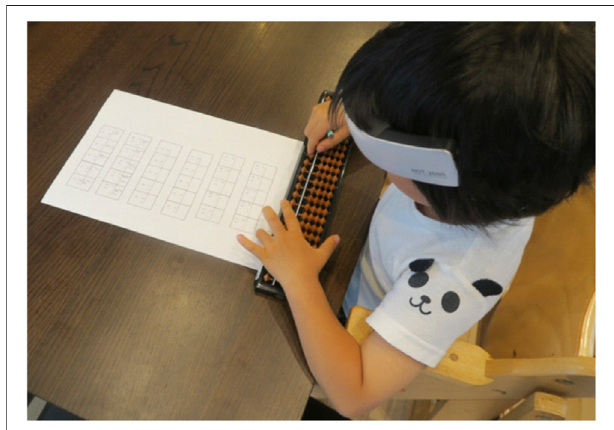
FIGURE 2 | Child calculates the task with an